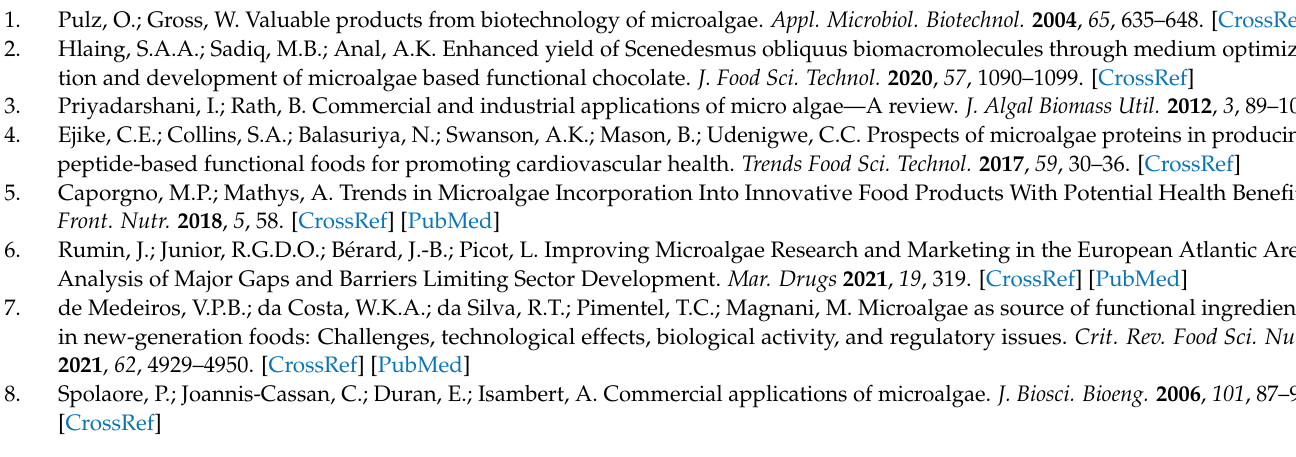
dards; Table S2: Experimental layout of the Plackett–Burman design and results of heterotrophic Chlorococcum amblystomatis -specific growth rates ( µ